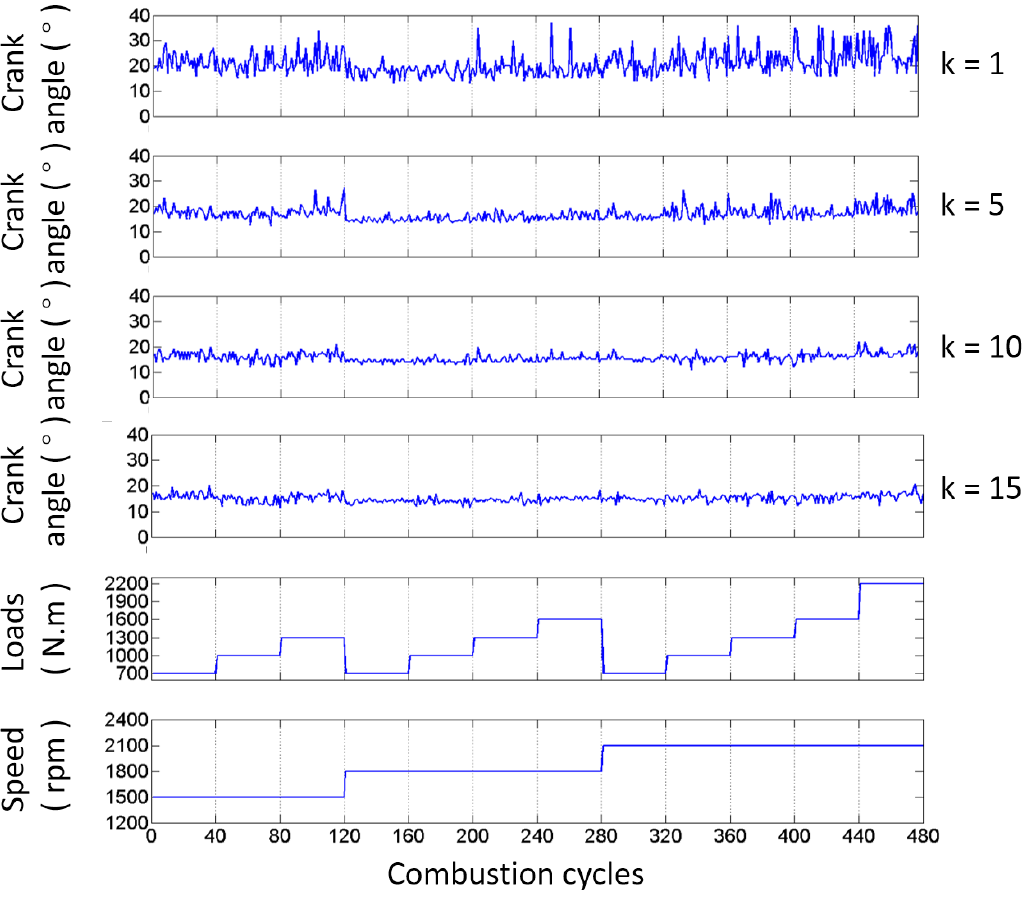
Figure 14. Angle and range fluctuations of the commencement of B1-cylinder exhaust valve closing impact in 480 combustion cycles calculated by the further enhanced method with different values of k.